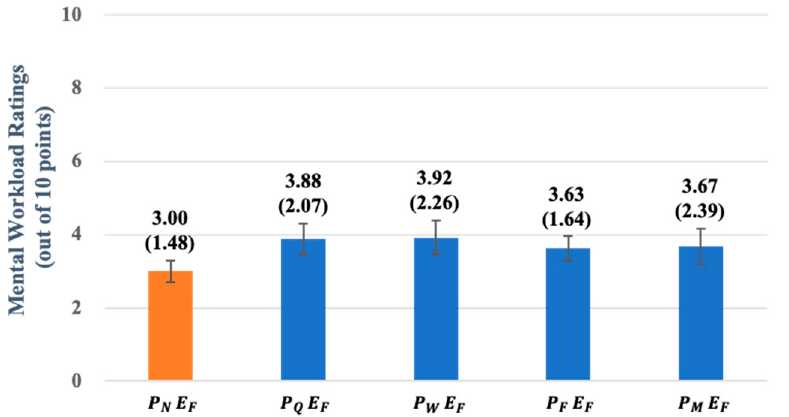
Figure 7. The mean and standard deviation values of mental workload experienced while performing the digit span task.